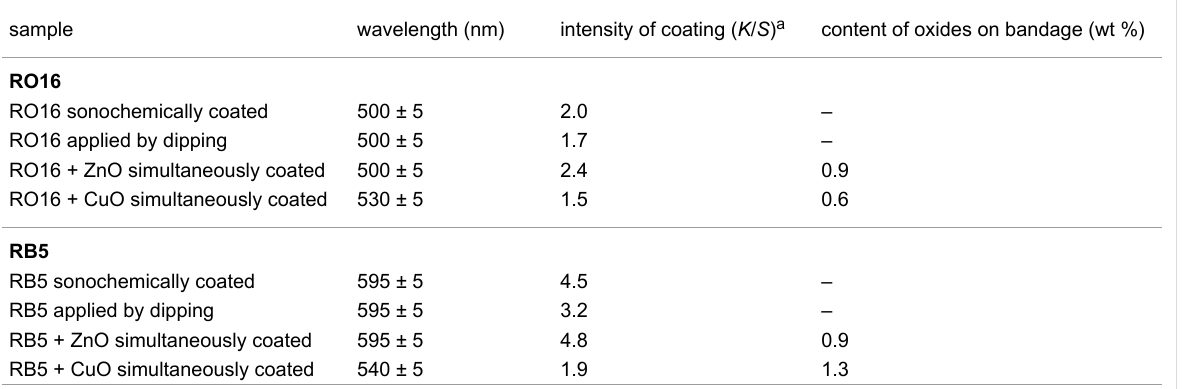
Table 1: Absorbance and ICP data of the various samples. sample